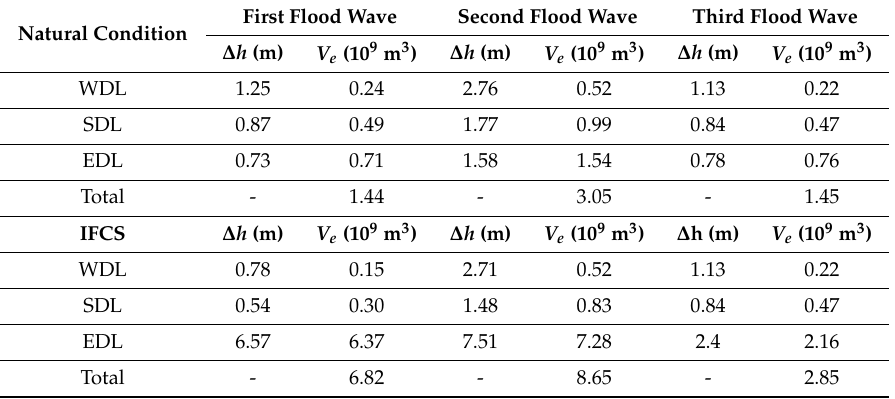
Table 3. Comparison of e ff ective flood control capacity before and after using the IFCS. WDL: West Dongting Lake; SDL: South Dongting Lake; EDL: East Dongting Lake. First Flood Wave Second Flood Wave Third Flood Natural Condition